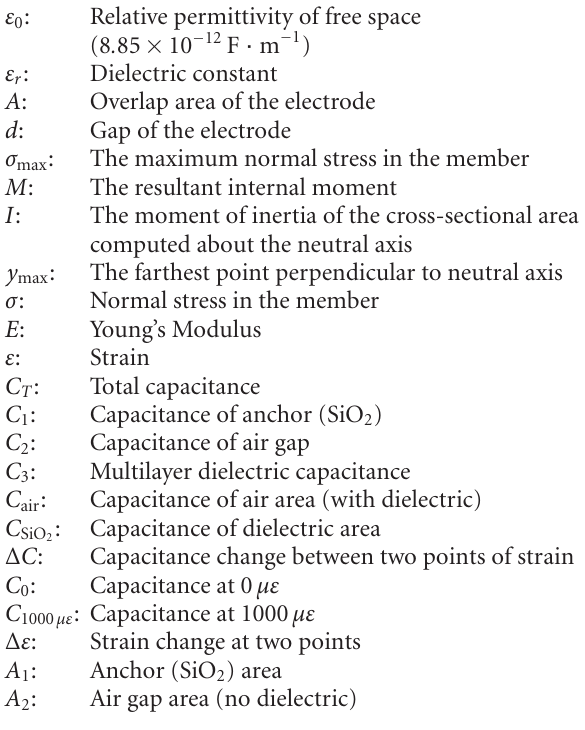
SiO 2 : Average gap of the electrodes opening during bending at the dielectric